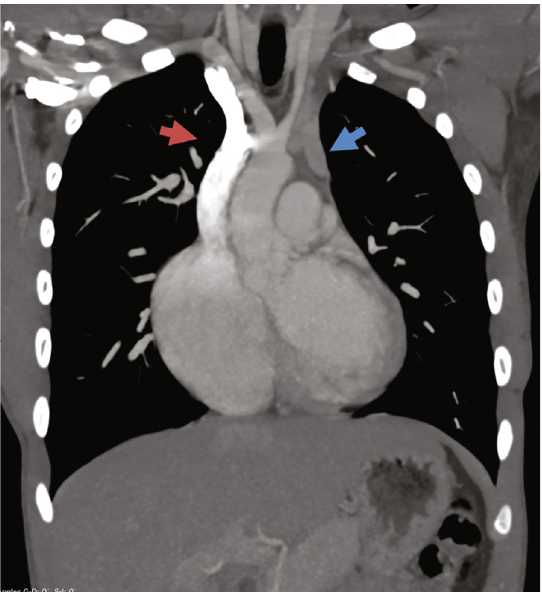
Figure 1: Coronal slide of the chest. Red arrow=right superior vena cava; blue arrow=persistent left superior vena cava.